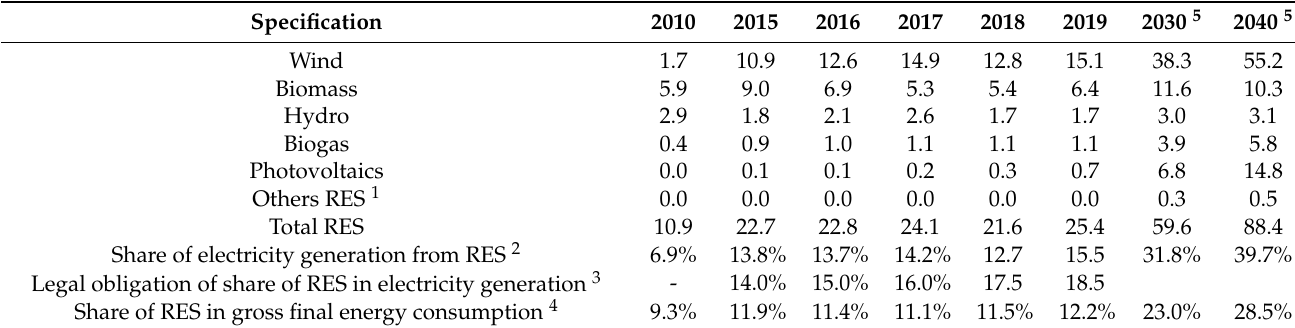
Table 3. Existing and planned electricity generation by source [TWh],